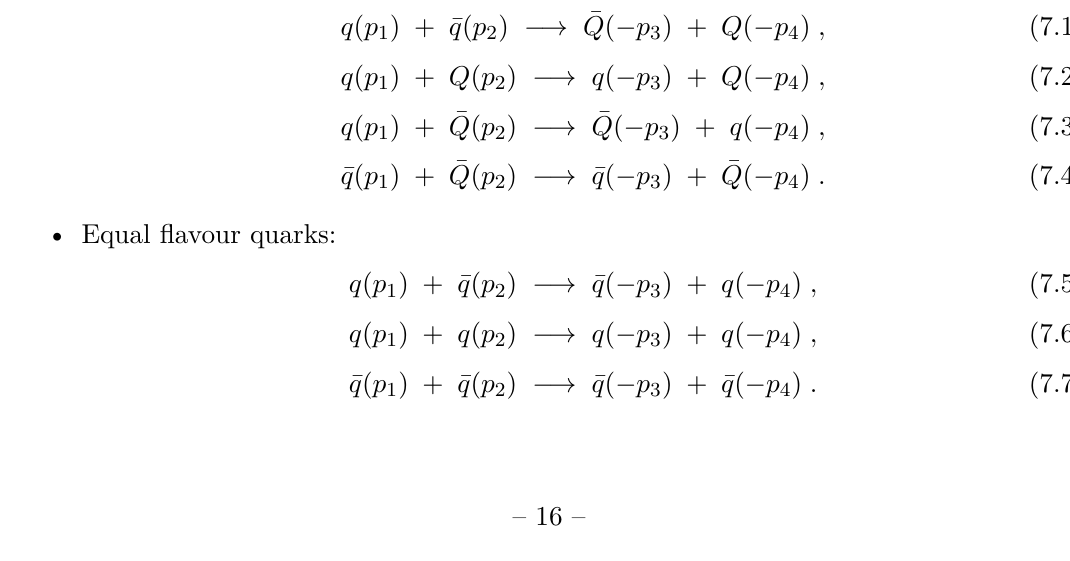
Figure 3 . Real (left) and imaginary (right) parts of the form factors H [ i ] , ( L ) (+ , − , − , +) . Colour components [ i ] and number of loops ( L ) are specified in the legends. Here, the colour index [1] is related to the colour structure δ refers to the coefficient of δ the corresponding